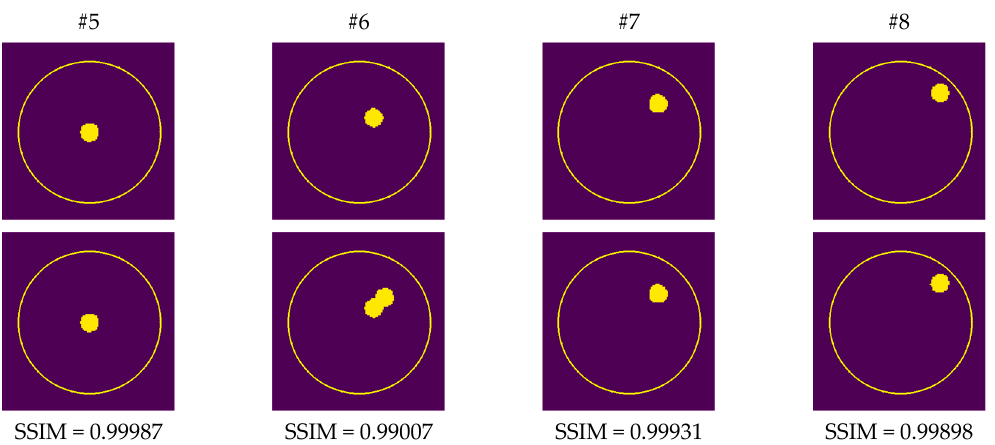
Figure 14. Comparison of samples of microwave images generated by the proposed CV-MWINet model for measurement data (tumor phantom in healthy phantom).